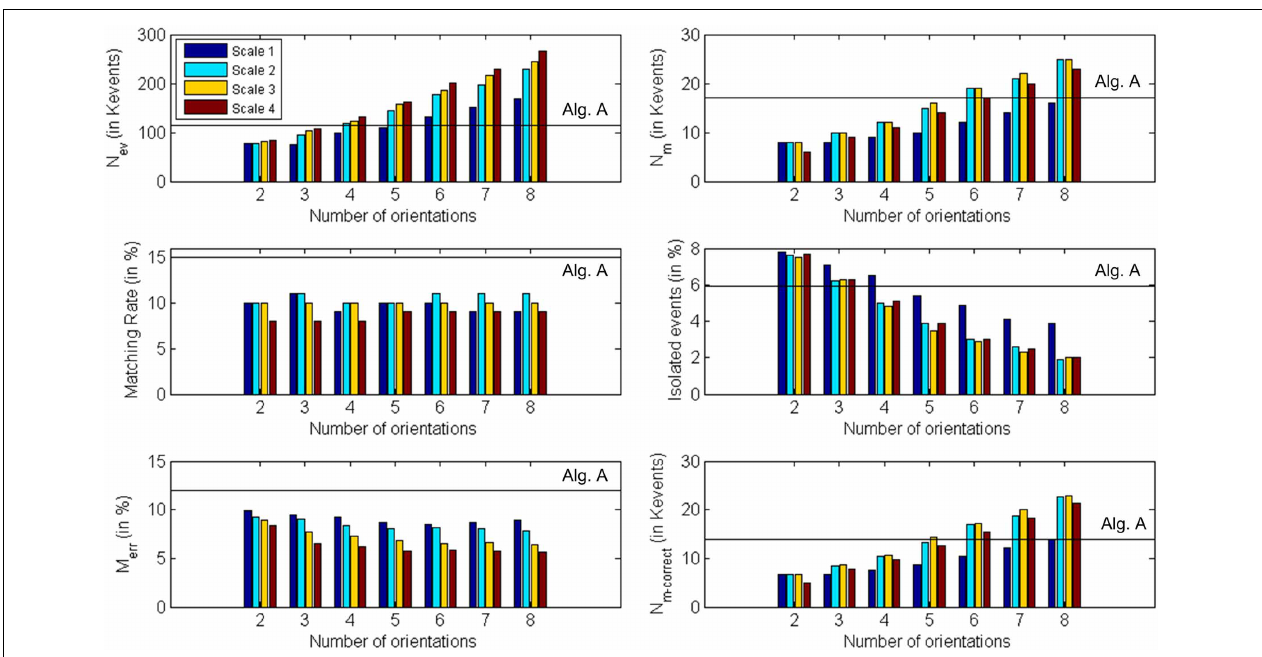
FIGURE 18 | Graphical representation of Table 2. Each subplot corresponds to a different row of the table, showing the obtained values for each number of orientations and scale. The black horizontal lines indicate the values obtained using algorithm A (0